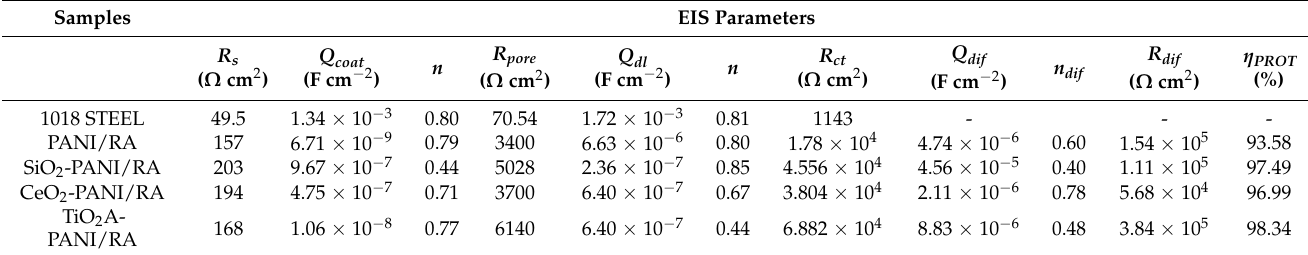
Table 2. EIS parameters obtained for uncoated steel and PANI-based coatings immersed in 3.5% NaCl solution. Samples EIS Parameters R s ( Ω cm 2